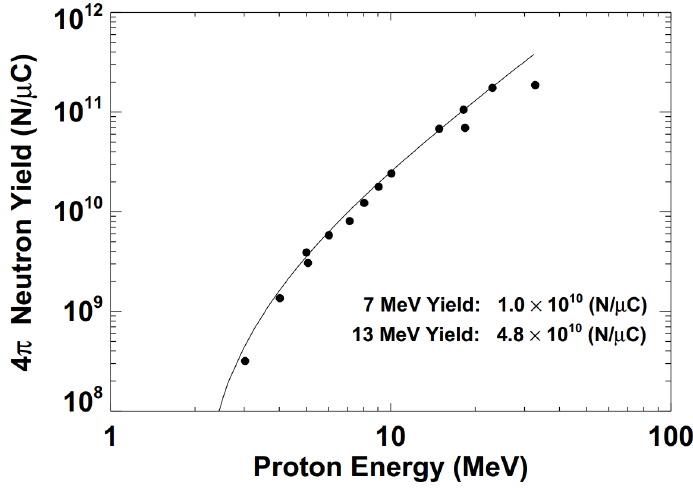
Figure 2. Collected experimental datum on neutron yields from 9 Be(p, xn) reactions and the fitting curve is Equation (1).